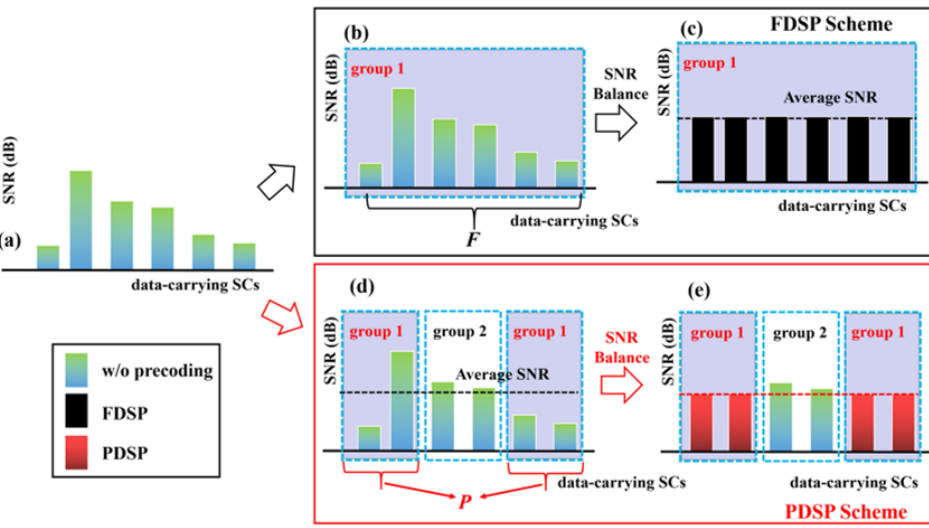
Figure 2. Schematic diagram of the PDSP scheme in the PS-enabled DMT system. ( a ) original SCs SNR, ( b ) SCs selected for FDSP, ( c ) SNR balance for FDSP, ( d ) SCs selected for PDSP and ( e ) SNR balance for PDSP.